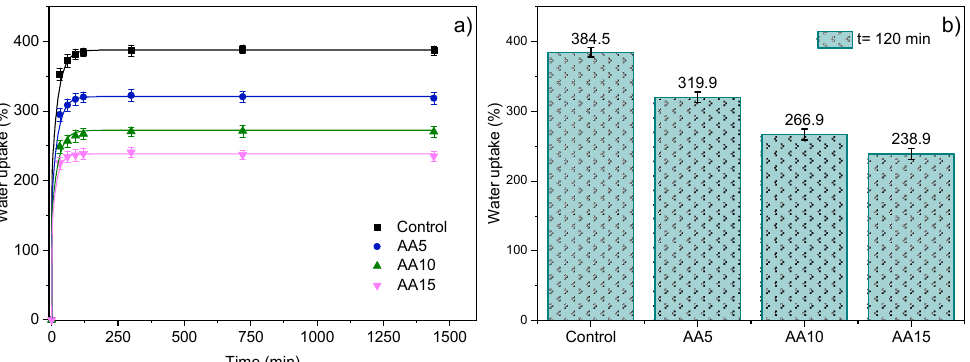
Figure 2. Water uptake capacity of WPI films as a function of ascorbic acid (AA) content ( a ) over time and ( b ) at 120 min (water uptake equilibrium values).